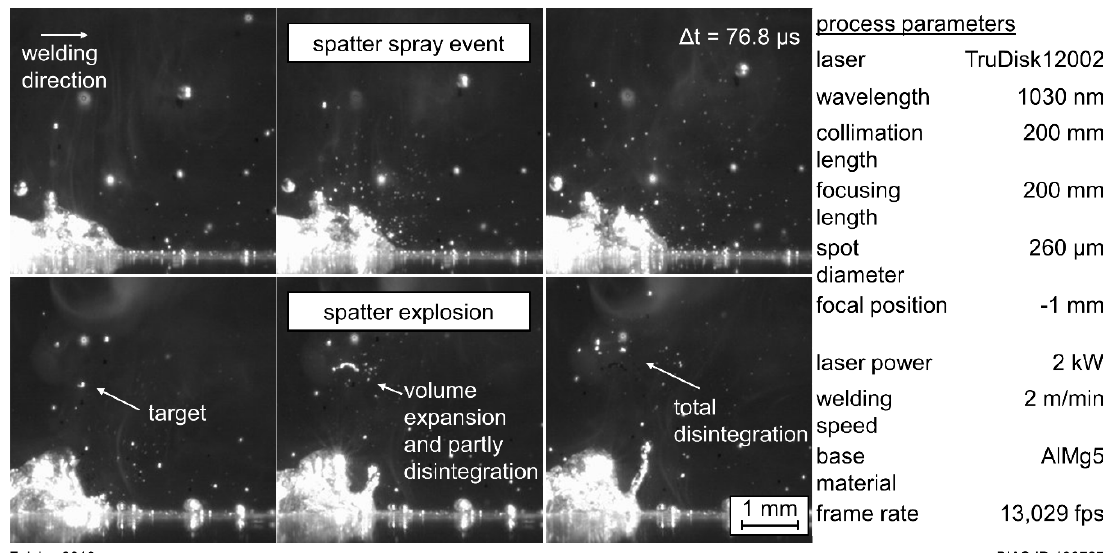
Figure 8. Frame series in the side view of a spray event and spatter explosion for AlMg5.